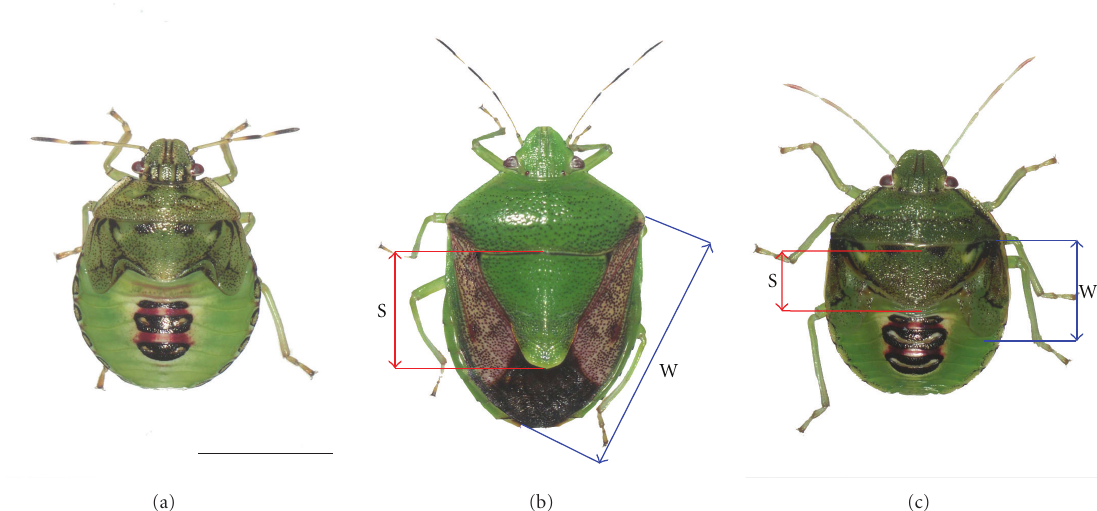
Figure 3: Bioassay for juvenilizing activity in Plautia stali . A last instar nymph (a), an adult (b), and a nymph-adult intermediate (c) obtained as a result of application of JH-active sample. Scale bar: 5mm. Arrows with labels W and S indicate forewing and scutellum lengths and pronotum width,